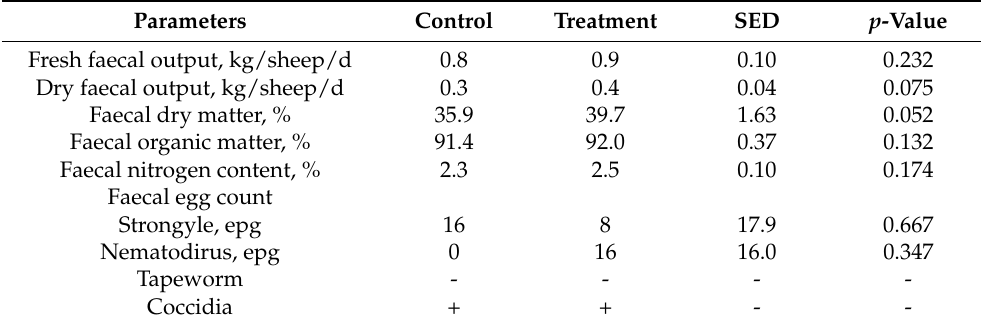
Table 3. Effects of feeding a diet containing 20% grape marc on faecal output, faecal composition, and egg count of merino sheep. Parameters Control Fresh faecal output, kg/sheep/d